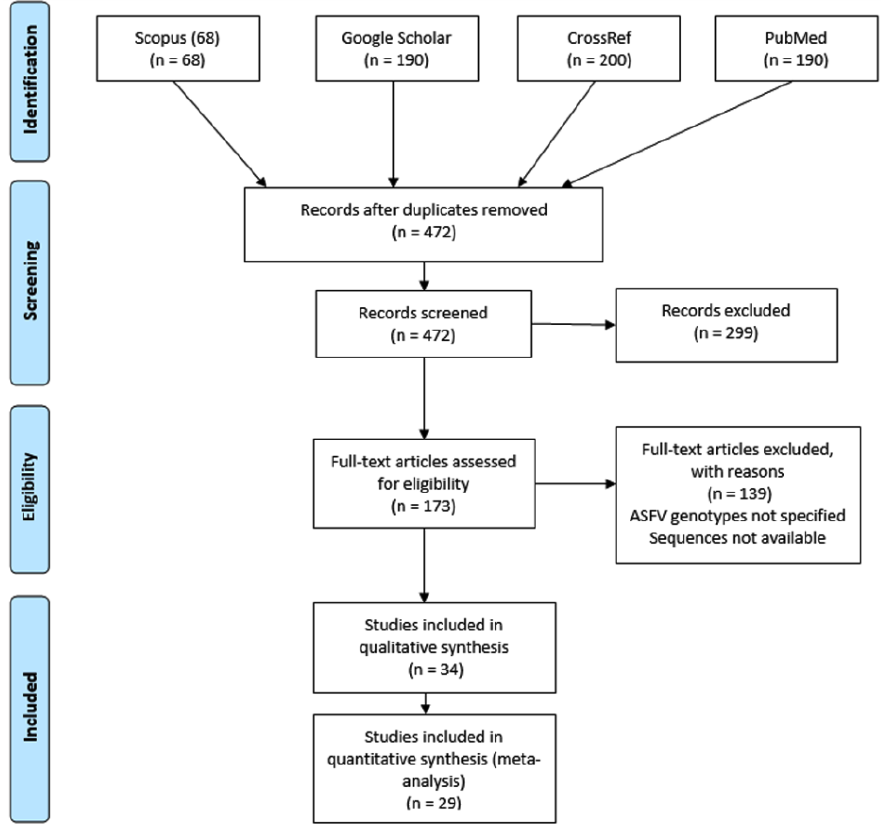
Figure 1. Preferred Reporting Items for Systematic Reviews and Meta-Analyses (PRISMA) flow chart of the literature search, screening, assessing eligibility, and article